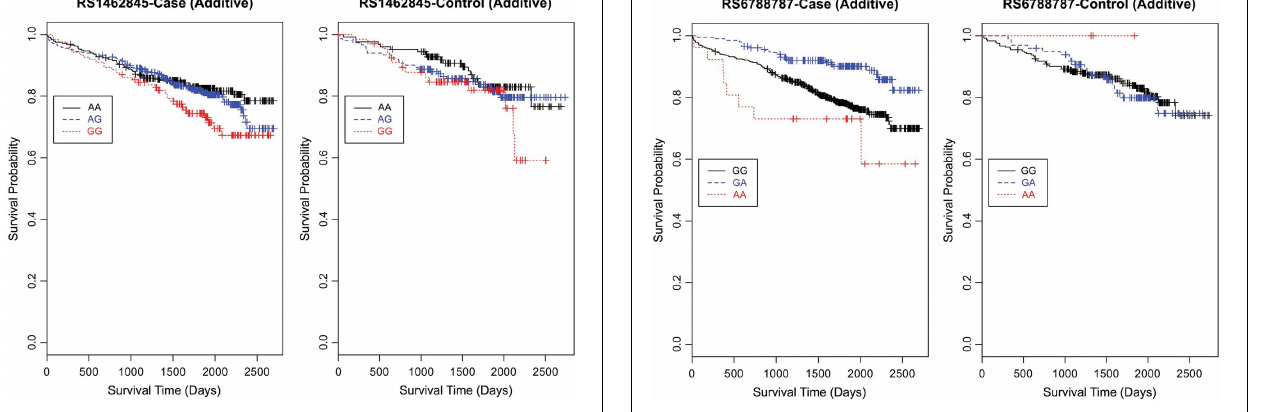
FIGURE 4 | Kaplan–Meier survival curves for CAD cases vs. controls in additive (genotype) model for LSAMP SNP rs6788787. X -axis displays the number of days from catheterization to death (all-cause mortality). Y -axis displays the Kaplan–Meier survival probability by genotype. A is the minor allele; GG, wild-type genotype (reference; black curve); GA, heterozygous genotype; and AA, risk homozygous genotype (red curve).